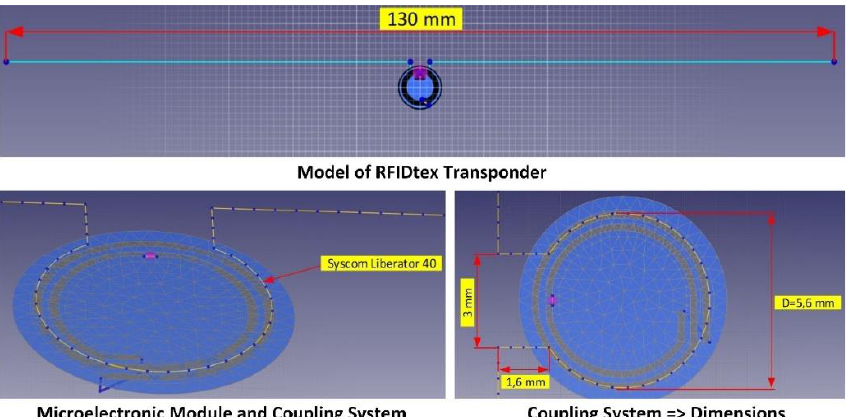
Figure 14. Numerical model of the antenna with microelectronic module (Syscom Liberator 40— conductive thread of antenna).